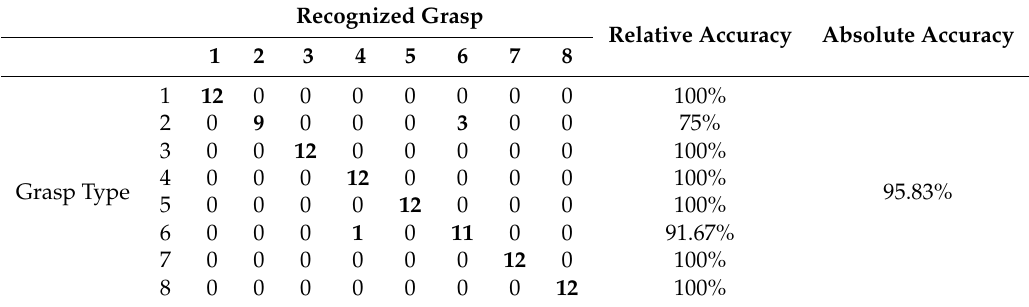
Table 4. Results: Volunteer